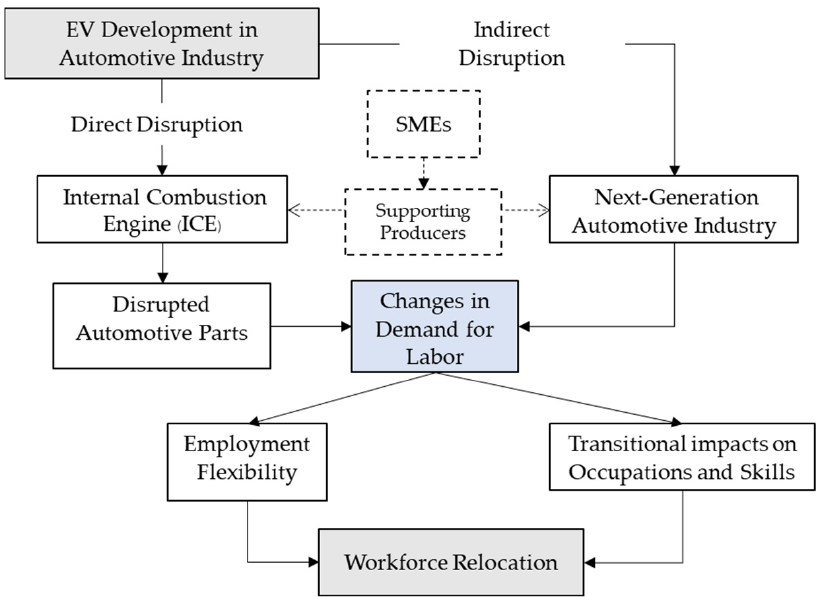
Figure 1. Conceptual framework. Source: developed by authors.